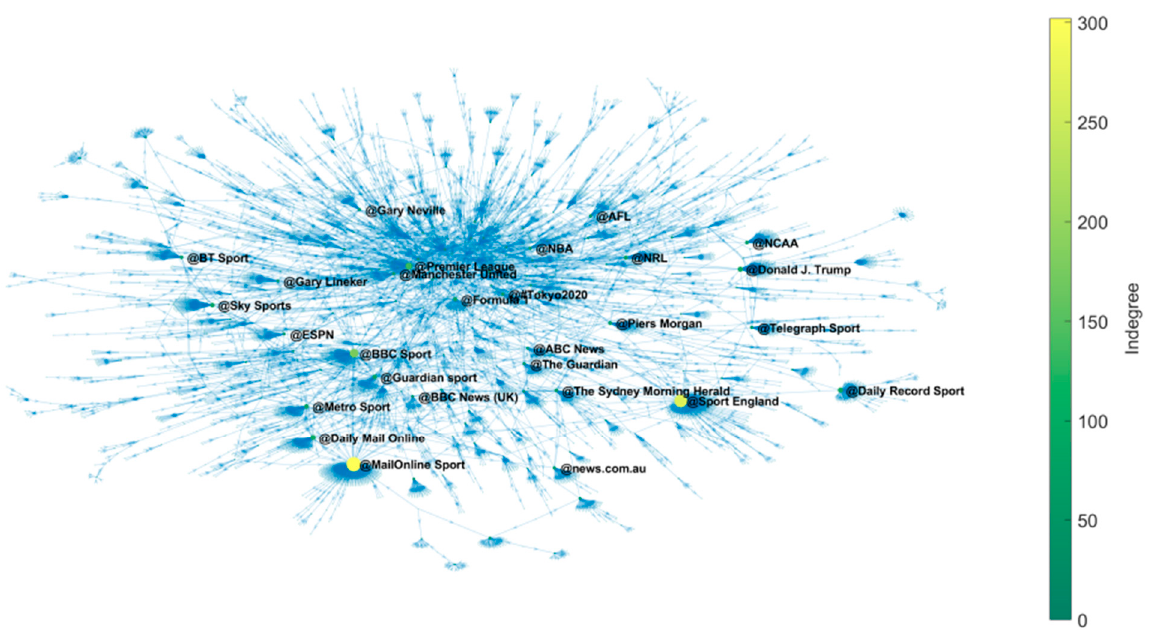
Figure 5. Subnet of mentions with a greater number of components .